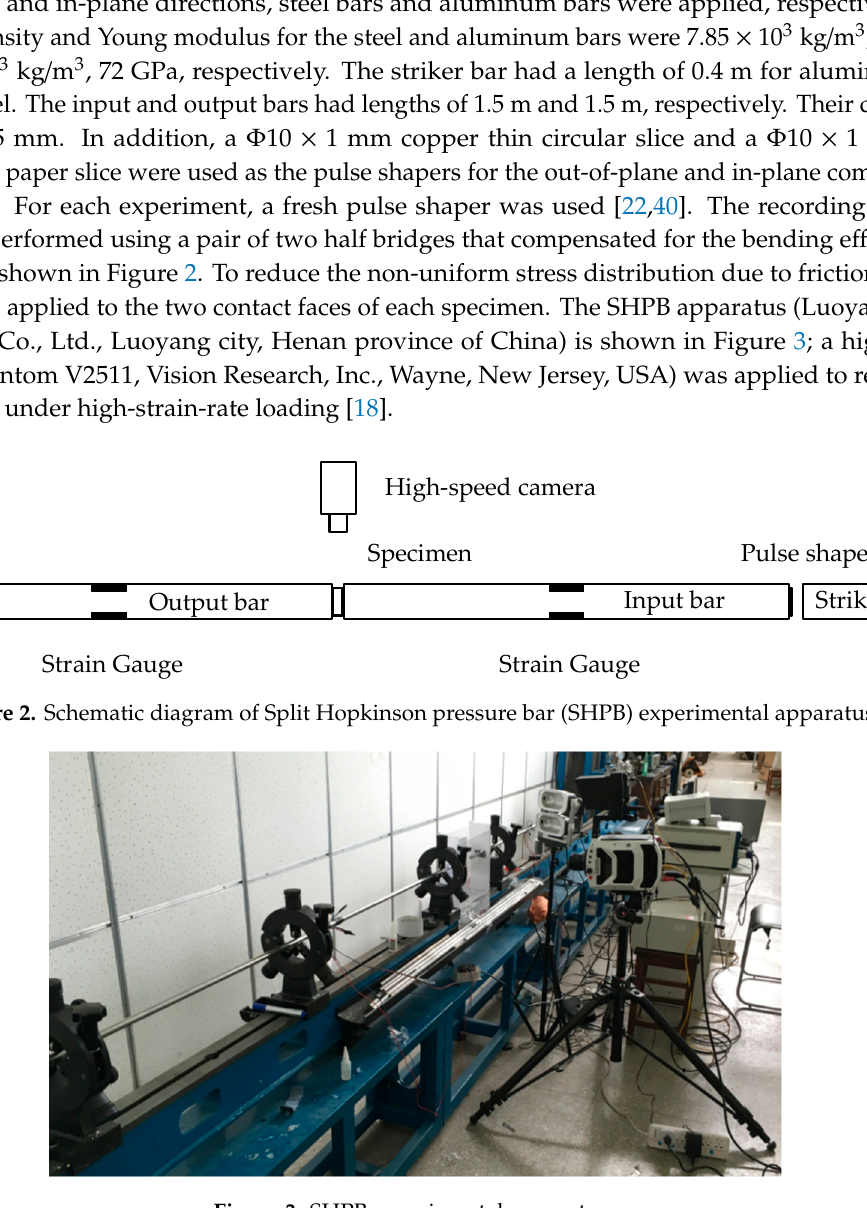
Figure 3. SHPB experimental apparatus.